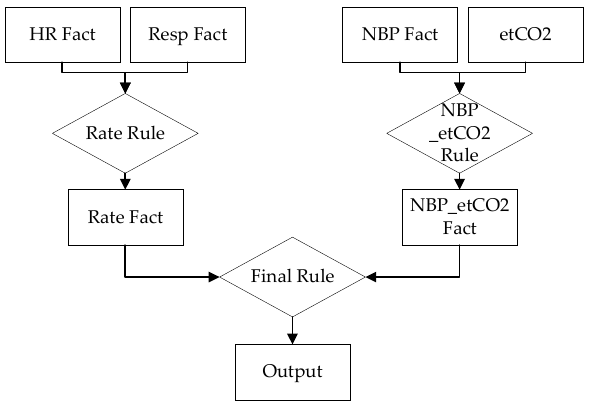
Figure 4. Second GDES network.